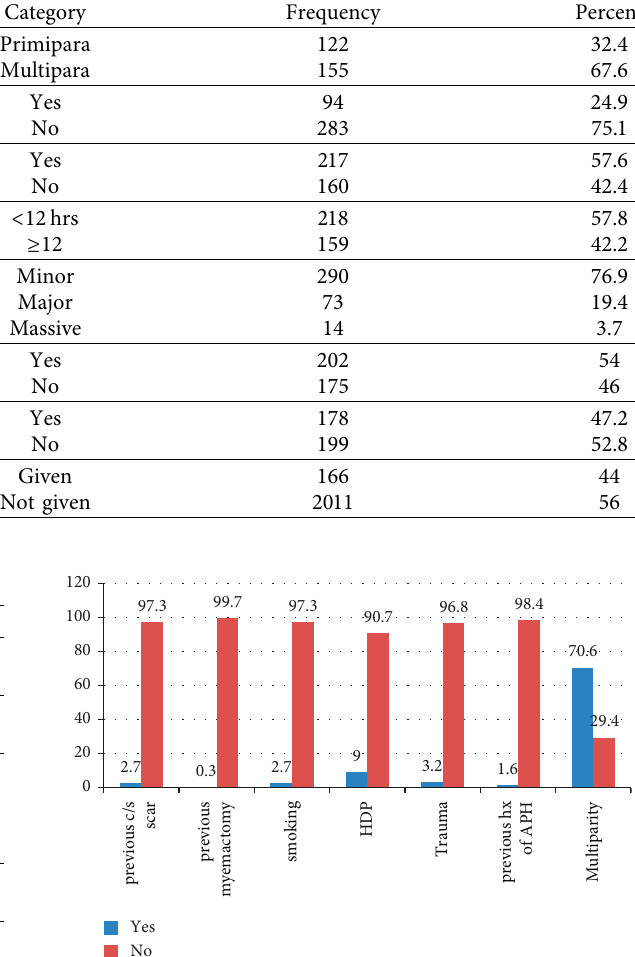
Table 2: Obstetric history on adverse perinatal and maternal outcome and associated factors.